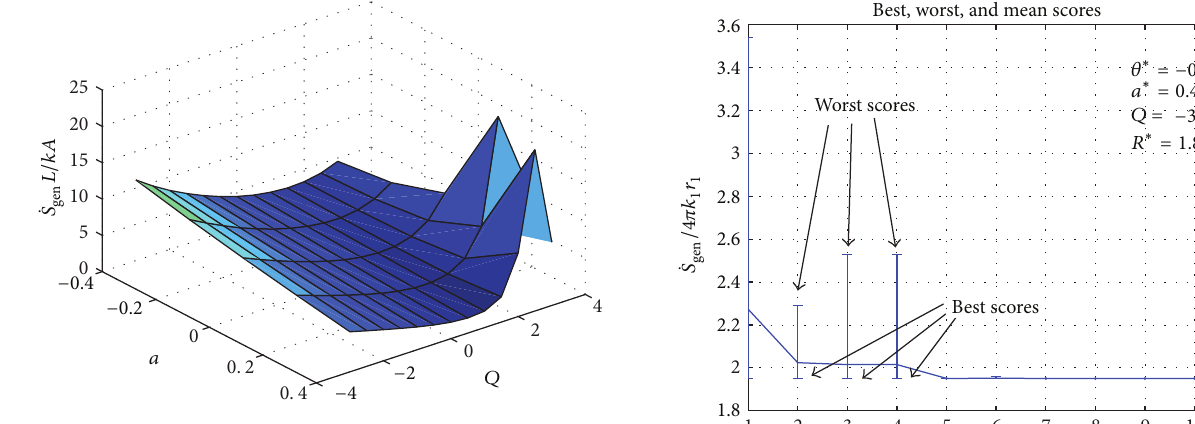
Figure 3: Variation of